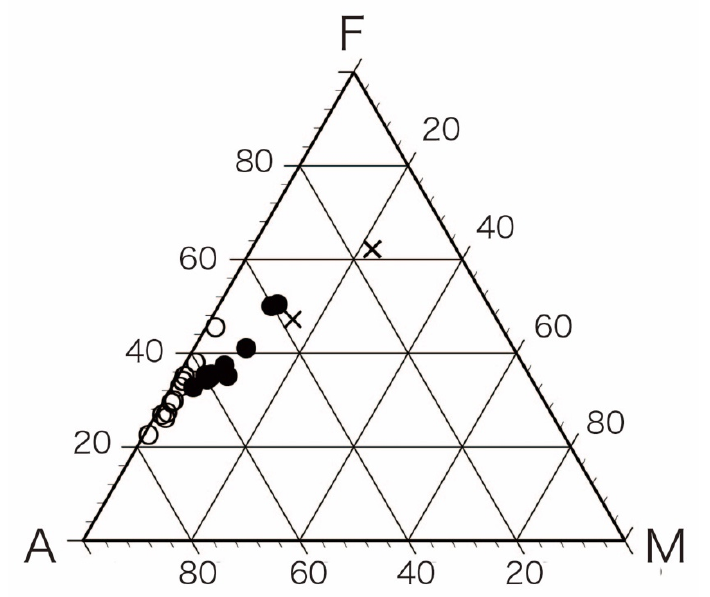
Figure 6. AFM (alkali–iron–magnesium) diagram for the rocks in the Hisakajima Island. F—total Fe as FeO*. M—MgO. A—K 2 O + Na 2 O. Solid circles—GD group samples. Open circles—HFG group samples.Cross marks—dike group samples.